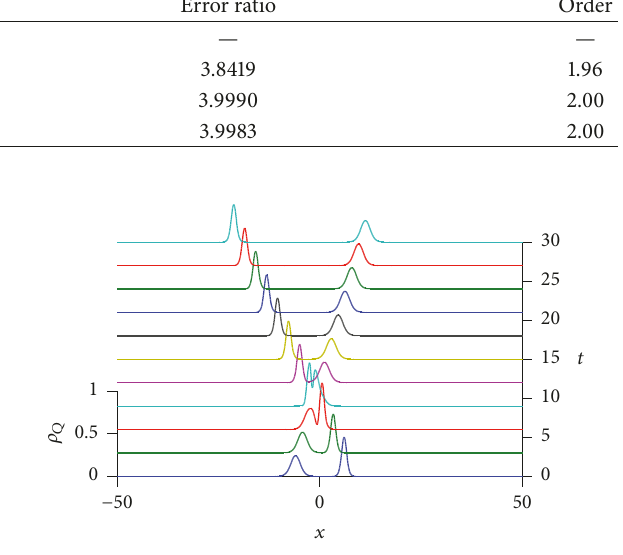
Figure 2: The time evolution of the charge density at 푥 = 0 by using the CM-IIF4 scheme with ℎ = 0.05 and 휏 = 0.01 (Example